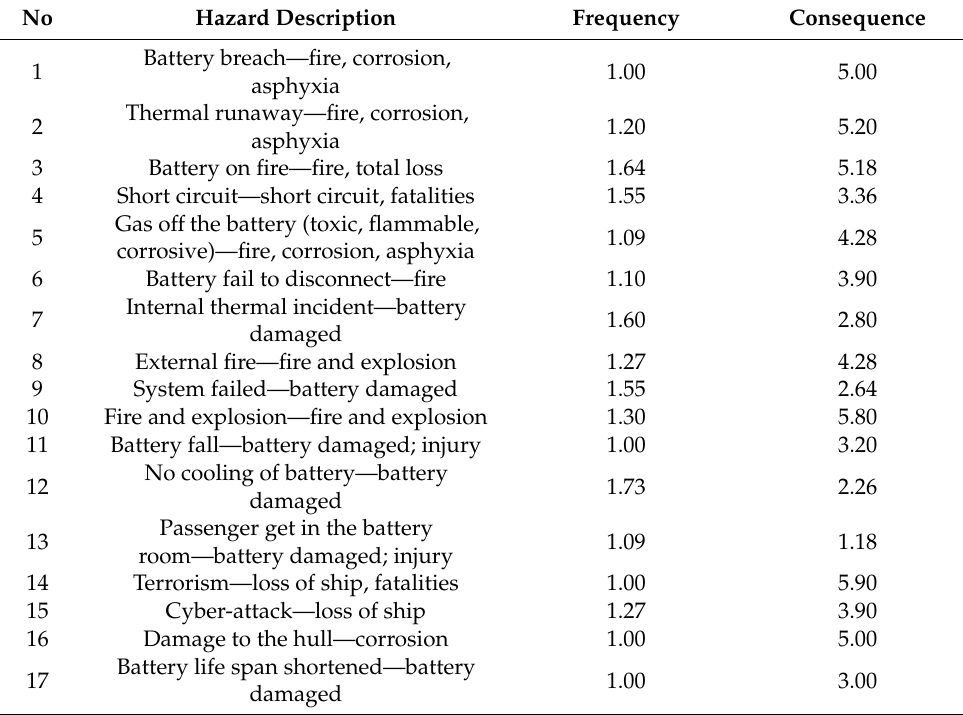
Table 6. HAZID questionnaire results—operation: voyage.